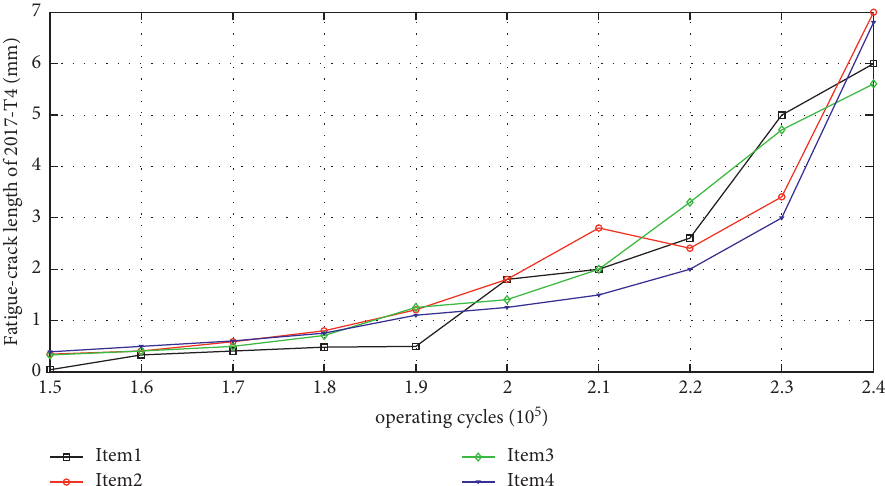
Figure 1: Degradation measurements of fatigue crack propagation data.